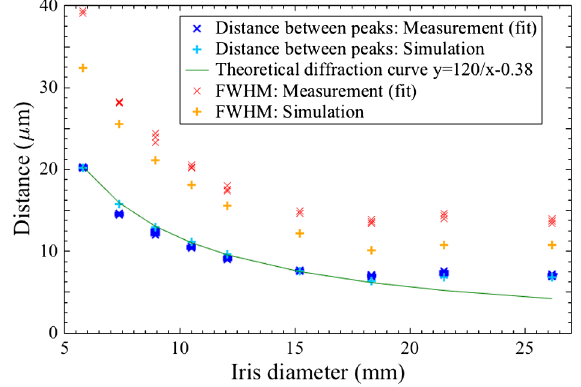
16. OTR PSF size for different iris diameters and λ ¼ 550 nm, γ ¼ 2500